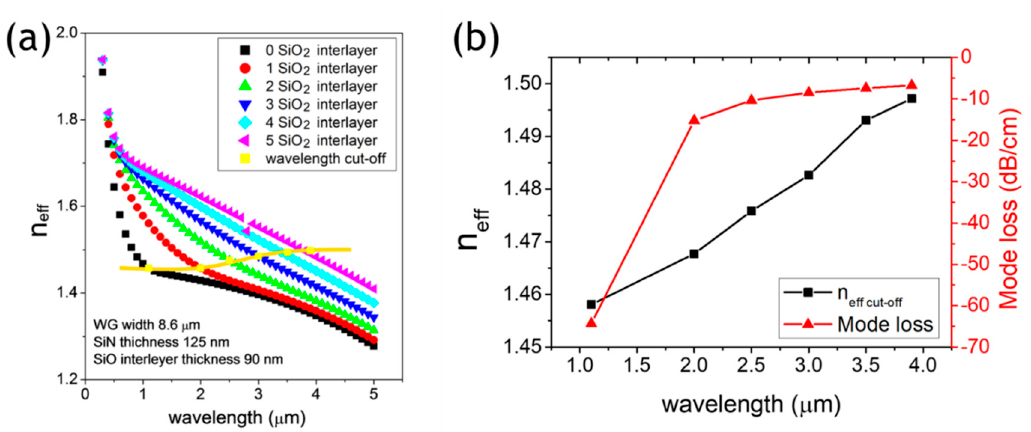
Figure 5. ( a ) n eff vs. wavelength for different numbers of SiO 2 interlayers. The cut-off wavelength is also plotted in the graph (yellow curve) and in ( b ) n eff at the cut-off wavelength and mode losses vs. wavelength are plotted.